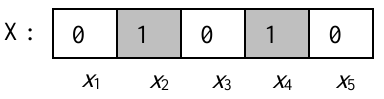
Figure 1. A candidate solution in proposed ACO-MNLS for a WDP with five